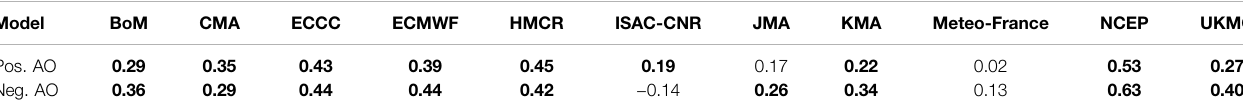
TABLE 2 | Correlations between the observed time-lag AO activities after the occurrence of the MJO event for 15 days and the AO S2S prediction skill during the fi rst 15 forecast days in the 11 S2S models. On each forecast day, the AO activity and prediction skill are further separated into eight MJO phases and no MJO (phase 0) according tothe MJO activity on the initial day. Therefore, the sample size foreach correlationis 15(days) × 9 (phases) (cid:1) 135. Moreover, correlations arealso separated into circumstances of the AO positive (Pos.) and negative (Neg.) phases on the initial day. As the prediction skill decreases during the fi rst 15 forecast days, the mean of the prediction skill during the nine MJO phases on each forecast day is removed before conducting the correlation. Thus, the decreasing trend is removed in the prediction skill. The correlation coef fi cients in bold are signi fi cant at the 5% level based on the Student ’ s